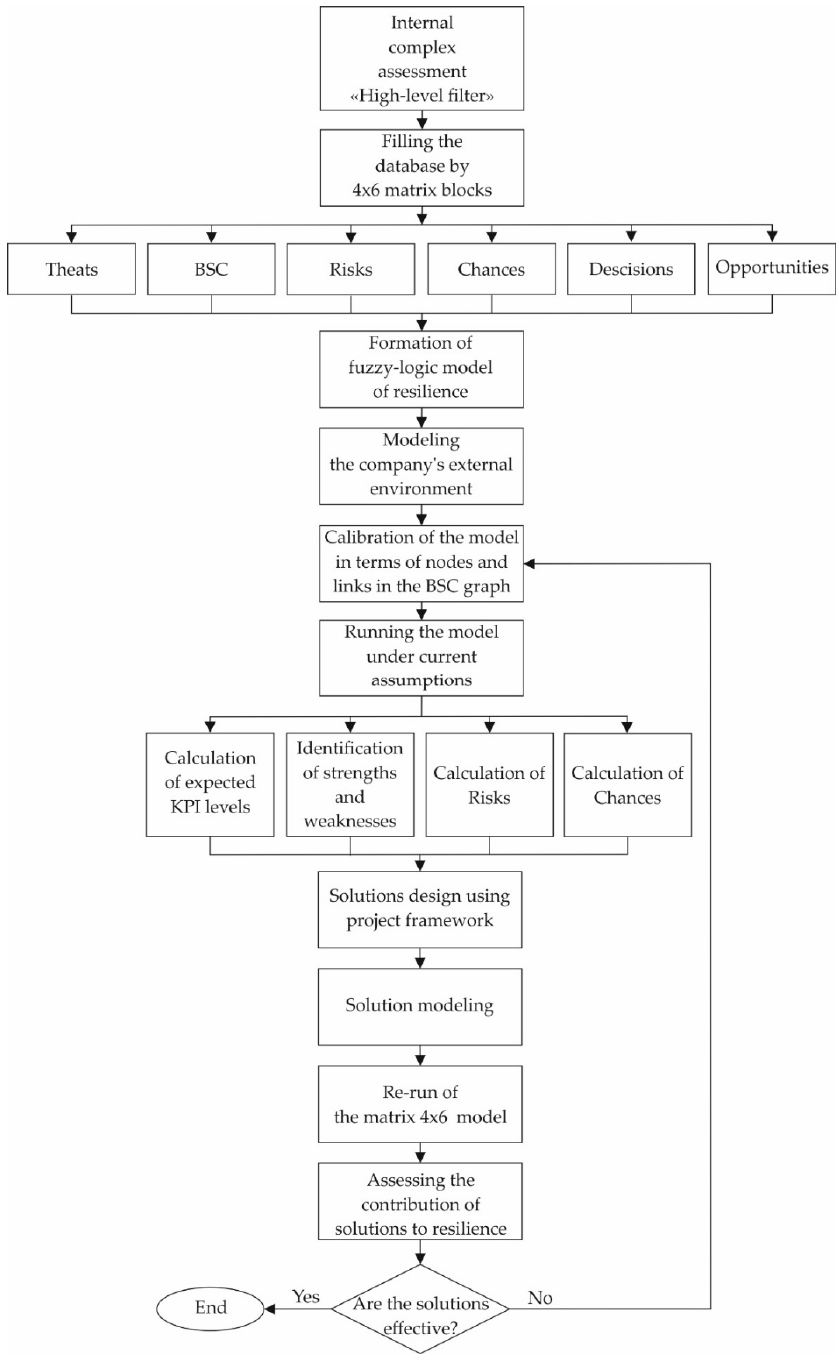
Figure 3. A comprehensive method for assessing resilience based on a 4x6 matrix model.